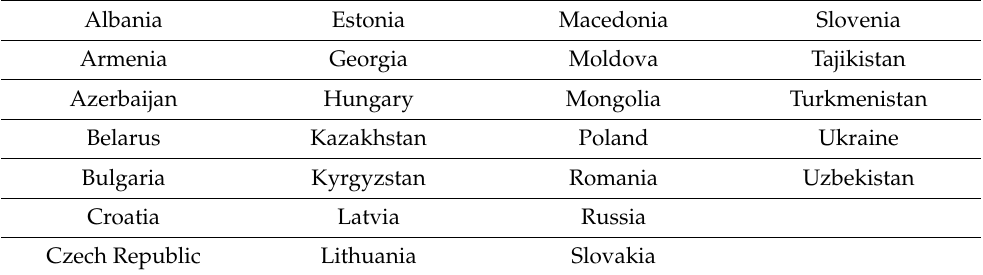
Table A3. Eastern Europe and Central Asia (post-Communist; including Mongolia)—26 Countries.